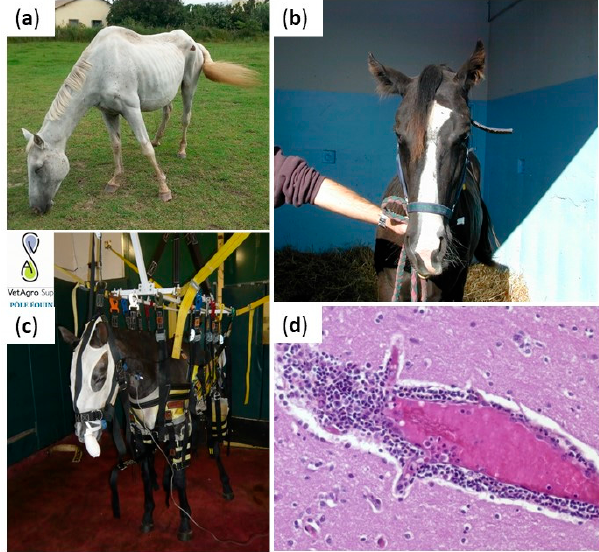
encephalitis viruses may experience posture deficits (increasing of the lift polygon in ( a )), cranial Figure 1. Major viruses causing encephalitis in equines. Virus classification according to ICTV 2019 nerve deficits (facial paralysis in ( b )), balance deficiencies (slings in ( c ) can be used to support paretic nomenclature [6] , structure and genome organisation are presented for viruses belonging to horses and avoid long and poor prognosis recumbency). Brain lesions are non-specific and include Herpesviridae , Rhabdoviridae , Flaviviridae , Bornaviridae and Togaviridae (adapted from ViralZone [7]). perivascular infiltration of inflammatory cells, observed in ( d ). Credits: Pr Agn è s Leblond, VetAgroSup, and Dr Eve Laloy, French Veterinary School of